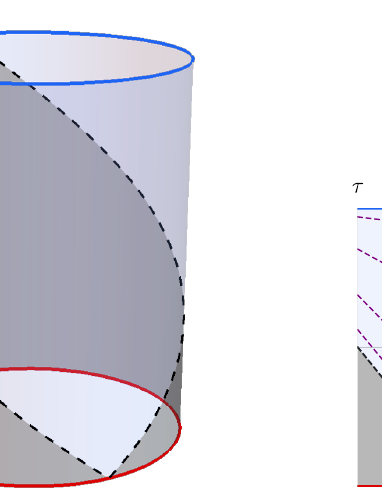
Figure 1 . Left: de Sitter spacetime dS d +1 as a hollow Minkowski cylinder, cf. equation (2.5). Time τ runs upwards from − π/ 2 to π/ 2 . Every horizonal timeslice corresponds to a copy of S d . The infinite past (resp. future) is shown as a solid red (blue) line. The light blue area is the Poincaré patch X 0 + X d +1 ≥ 0 ; the boundary between the two patches is shown as a dashed line. Right: Penrose diagram of the same spacetime, specializing to d = 1 . Spatial slices S 1 are parametrized by an angle φ ∼ φ + 2 π . Several timeslices of fixed η < 0 in the conformal coordinates (2.7) are shown as thin purple lines. The left and right sides of the diagram are identified, owing to the periodicity of φ